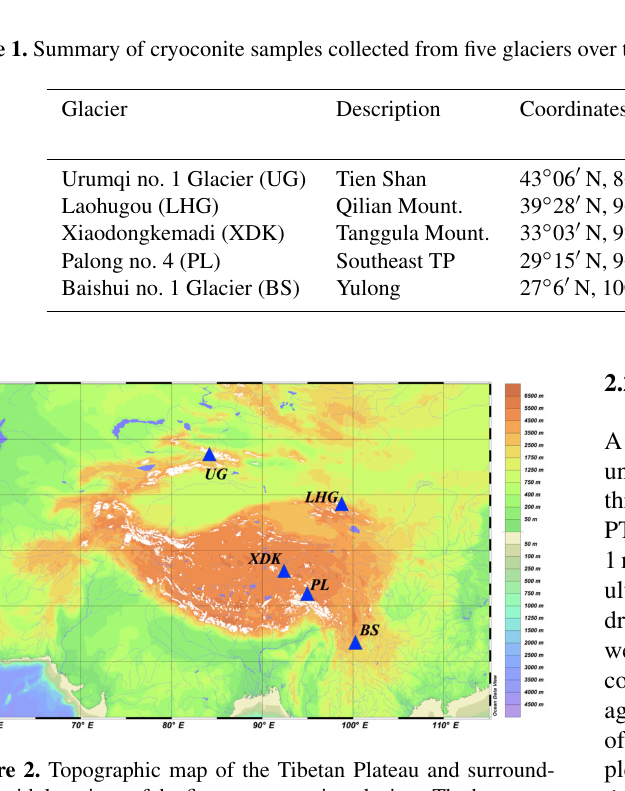
Figure 2. Topographic map of the Tibetan Plateau and surround- ings, with locations of the five representative glaciers. The base map was created using Ocean Data View software (Schlitzer,